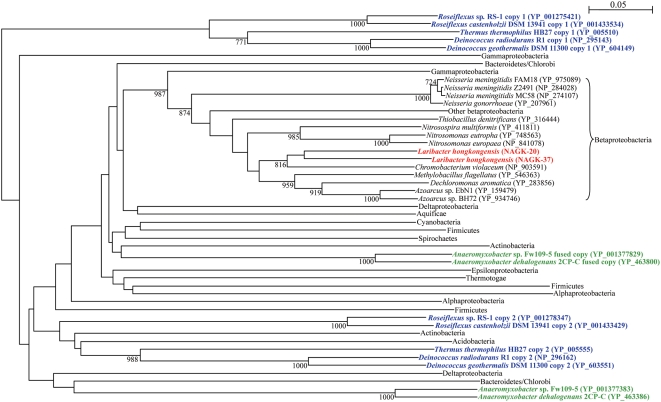
Phylogenetic relationships among N-acetyl-L-glutamate kinase (NAGK)-20 and NAGK-37 of L. hongkongensis and their homologues in other bacteria.NAGK-20 and NAGK-37 of L. hongkongensis were highlighted in red. Thermus thermophilus, Deinococcus geothermalis, Deinococcus radiodurans, Roseiflexus castenholzii and Roseiflexus sp. RS-1 with two distinct copies of argB were highlighted in blue, whereas Anaeromyxobacter sp. Fw109-5 and Anaeromyxobacter dehalogenans 2CP-C with one distinct copy of argB and one copy of argJ fused with argB were highlighted in green. Bootstrap values were calculated from 1,000 trees. The scale bar indicates the estimated number of substitutions per 20 amino acids. All names and accession numbers are given as cited in the GenBank database.